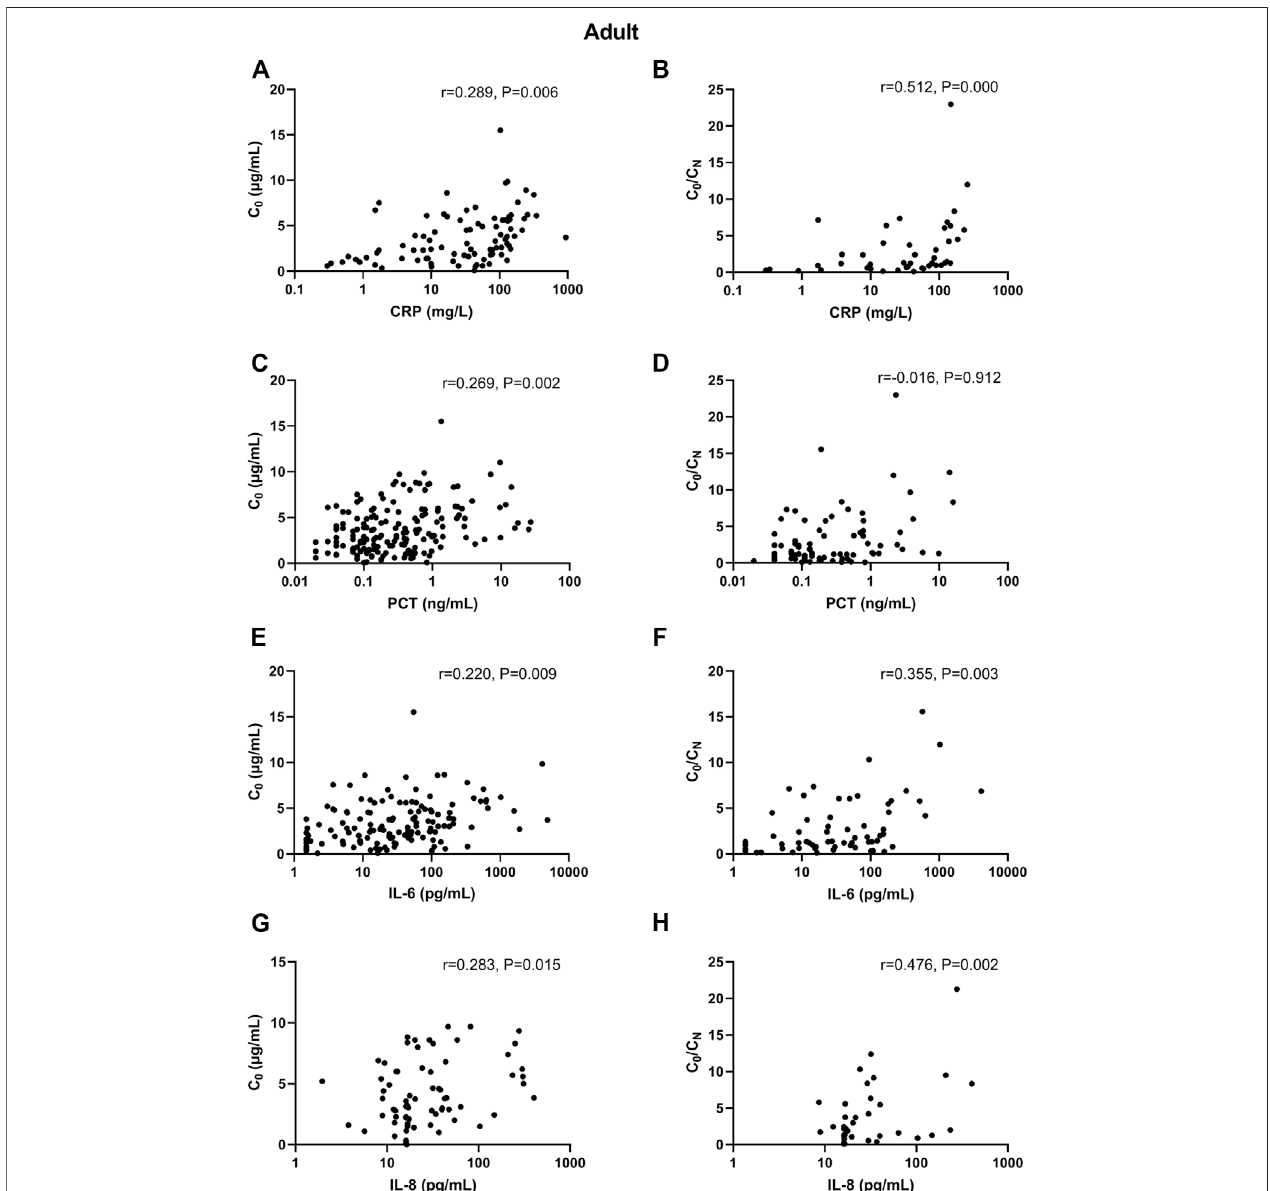
FIGURE1| AssociationofCRP,PCT,IL-6,andIL-8plasmalevelswithVCZC 0 andVCZC 0 /C N inadult patients. (A,B) TheCRPlevelswerepoorlyassociatedwith VCZ C 0 but moderately associated with VCZ C 0 /C N ratio. (C,D) The PCT levels were poorly associated with VCZ C 0 but not associated with VCZ C 0 /C N ratio. (E,F) The IL-6 levels were poorly associated with VCZ C 0 but moderately associated with VCZ C 0 /C N ratio. (G,H) The IL-8 levels were poorly associated with VCZ C 0 but moderately associated with VCZ C 0 /C N ratio.